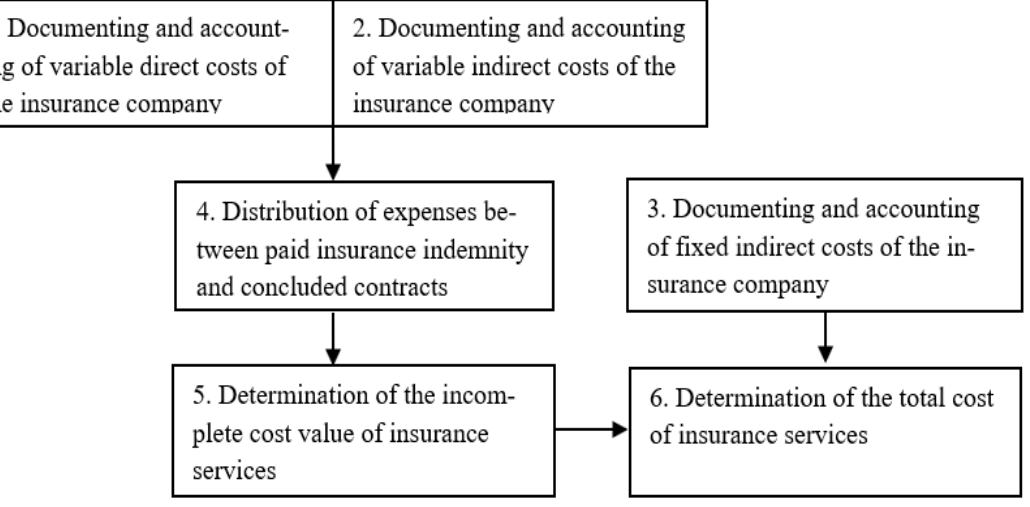
Figure 3. The scheme of accounting management system in insurance companies (developed by the author).